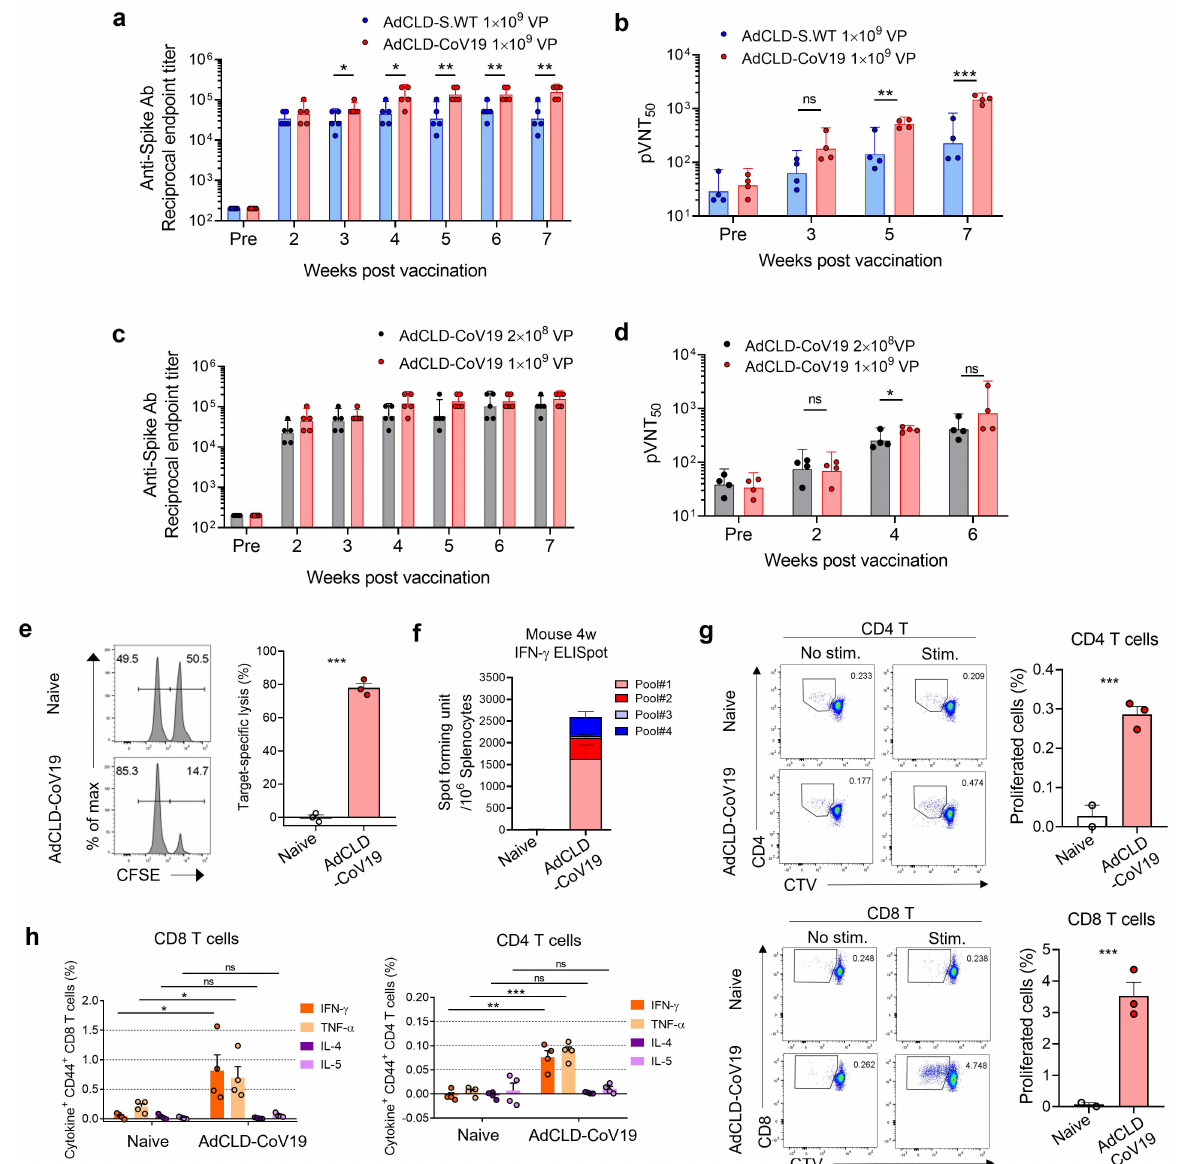
Figure 2. Immunogenicity of AdCLD-CoV19 in mice. ( a , b ) Naïve BALB/c mice were vaccinated with 1 × 10 9 VP of AdCLD-CoV19 or AdCLD-S.WT with a single intramuscular injection and serums were collected at indicated time points. Serums were assessed for S-specific Abs by ELISA ( a ) and neutralizing Abs by SARS-CoV-2 pseudovirus neutralization test, pVNT50, 50% pseudovirus neutralization titer ( b ). ( c , d ) Naïve BALB/c mice were vaccinated with 1 × 10 9 VP or 2 × 10 8 VP of AdCLD-CoV19, and collected serums were assessed for S-specific Abs by ELISA ( c ) and neutralizing Abs by SARS-CoV-2 pseudovirus neutralization test ( d ). ( e ) In vivo cytotoxicity analysis of AdCLD- CoV19-vaccinated mice. CFSE hi , peptide-loaded target; CFSE lo , peptides-unloaded control. The percentages of specific-peptides-loaded target cell lysis are shown as a graph. ( f ) IFN- γ -secreting T cells were measured by ELISpot assay from splenocytes stimulated with each peptide pool (see Methods). ( g ) CD4 (upper) and CD8 (lower) T cell proliferation under peptides stimulation was assessed by flow cytometry. The percentages of T cells that proliferated at least once are shown as graphs. ( h ) Ten weeks after vaccination, splenocytes were restimulated with peptide pools for 6 h and intracellular cytokine staining (ICS) was conducted to measure T cell responses. The percentages of cytokine expression from CD4 (left) and CD8 (right) T cells are depicted as graphs. Two-tailed Student’s t -test was used for the analysis. *, p < 0.05; **, p < 0.01; ***, p < 0.001; ns, not